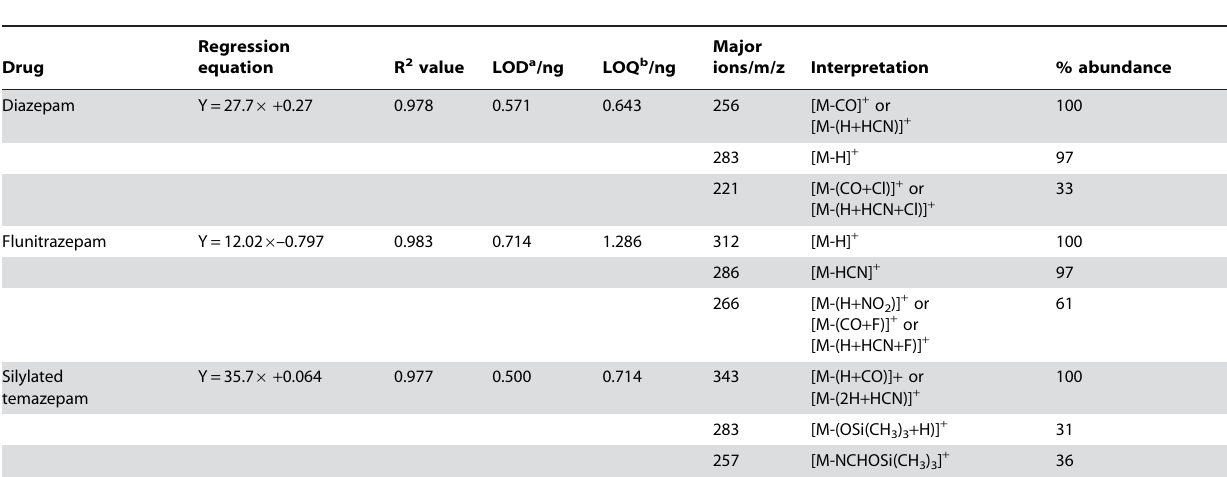
Table 3. Calibration and mass spectra interpretation for diazepam, silylated temazepam and flunitrazepam standards.